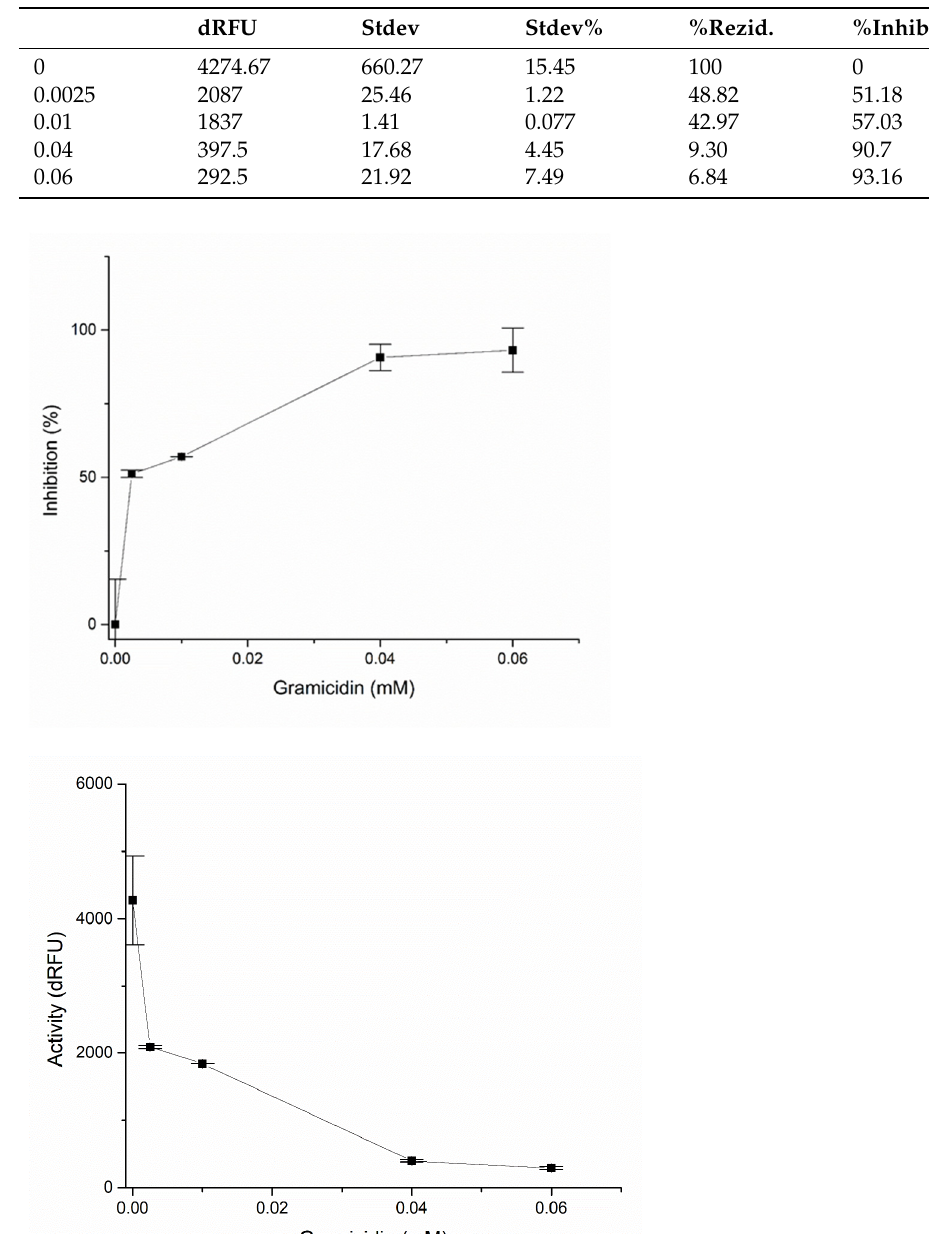
Table 2. Kinetic data for the inhibition of PL Pro by gramicidin D.